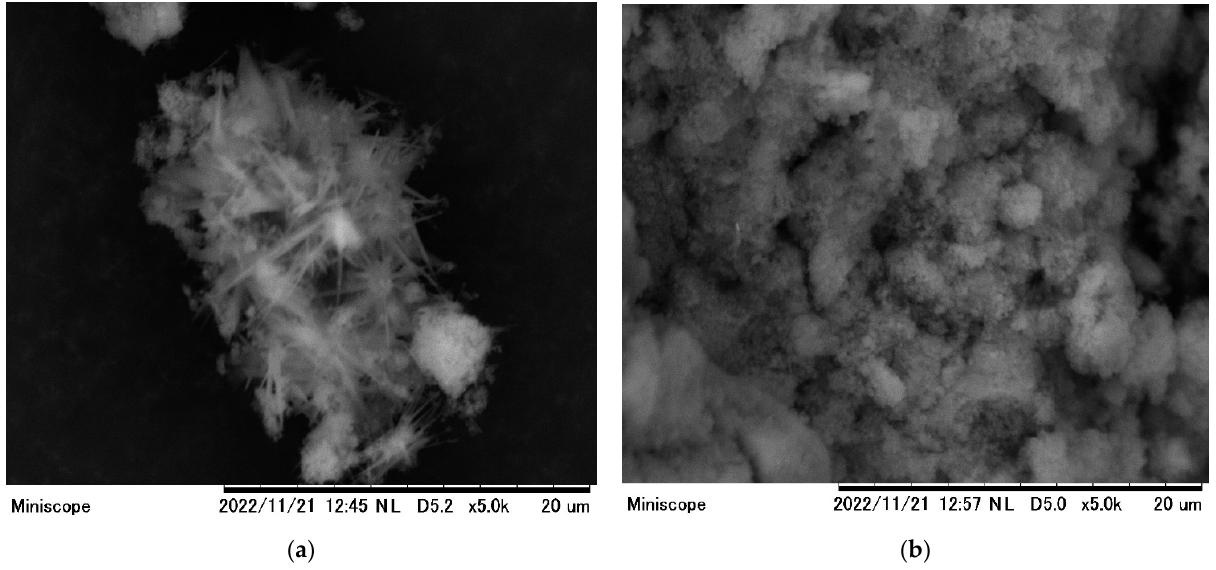
Figure 1. SEM images of ZLCH-Fe; ( a ) before nitrate adsorption; ( b ) after nitrate